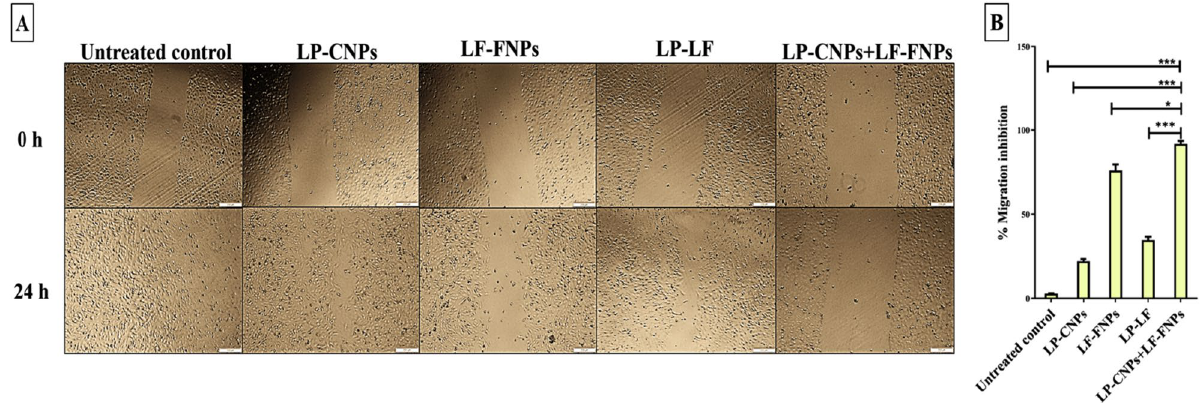
Figure 7. Anti-migration potency using wound healing assay. ( A ) Microscopic image of the scratched wound area in the untreated and LP-CNPs, LF-FNPs, LF-LP and LP-CNPs + LF-FNPs -treated Caco2 cells at 0 and 24 h (Magnification ×40; scale bar 200 µm); ( B ) relative migration inhibition percentages. All values are demonstrated as mean ± SE. LP-CNPs + LF-FNPs are statistically significant with other formulas at p < 0.05*, p < 0.005**, p < 0.0005***. CNPs: CuO nanoparticles; FNPs: iron nanoparticles; LF: lactoferrin; LP: